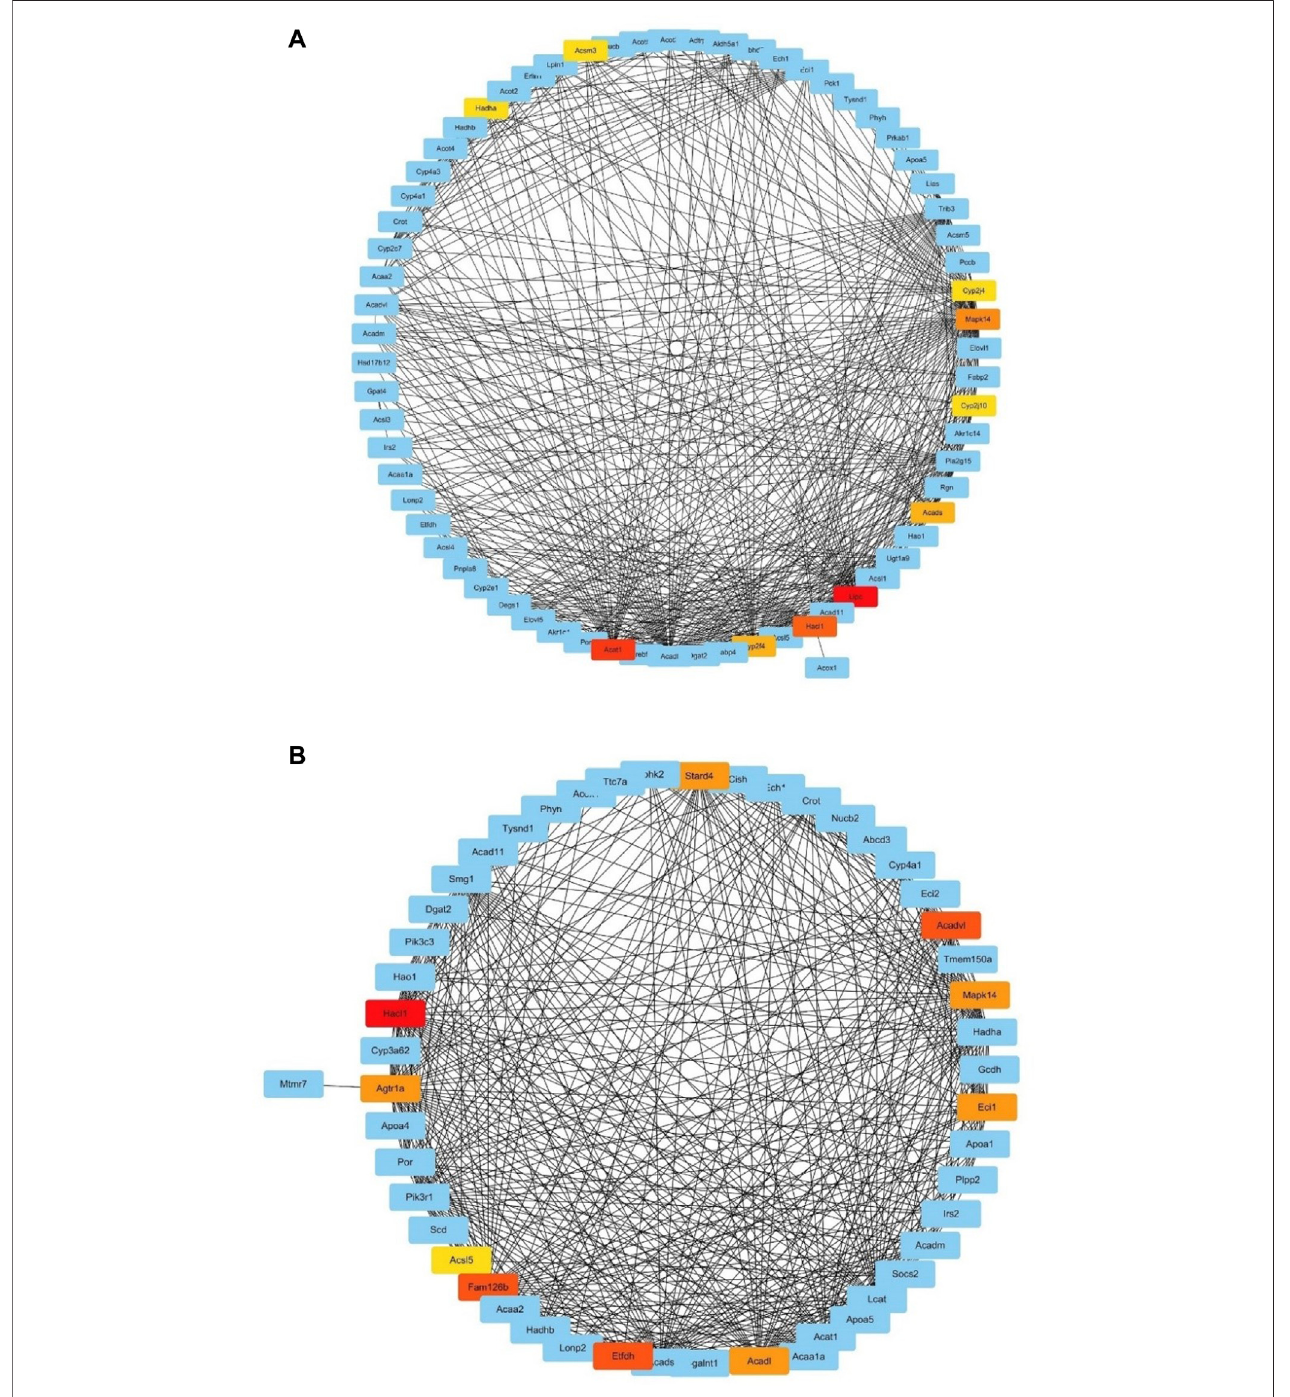
FIGURE6| Subnetworksbasedonmaximalcliquecentralityvalues. (A) SubnetworkoftheGOterm “ fattyacidmetabolicprocess. ” (B) SubnetworkoftheGOterm “ lipid modi fi cation. ” The red nodes (higher MCC value) and yellow nodes (lower MCC value) represent genes with the top 10 MCC values.